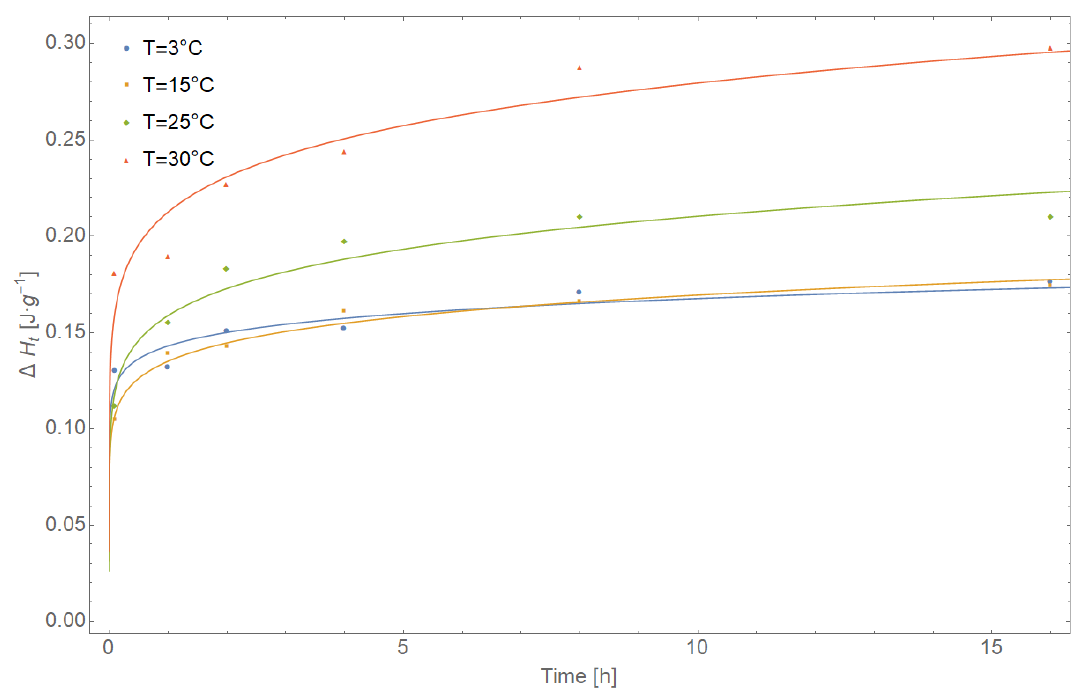
Figure 4. ΔH t as a function of ageing time for various ageing temperatures. Figure 4. ∆ H t as a function of ageing time for various ageing temperatures. Table 3. The results of the Residual